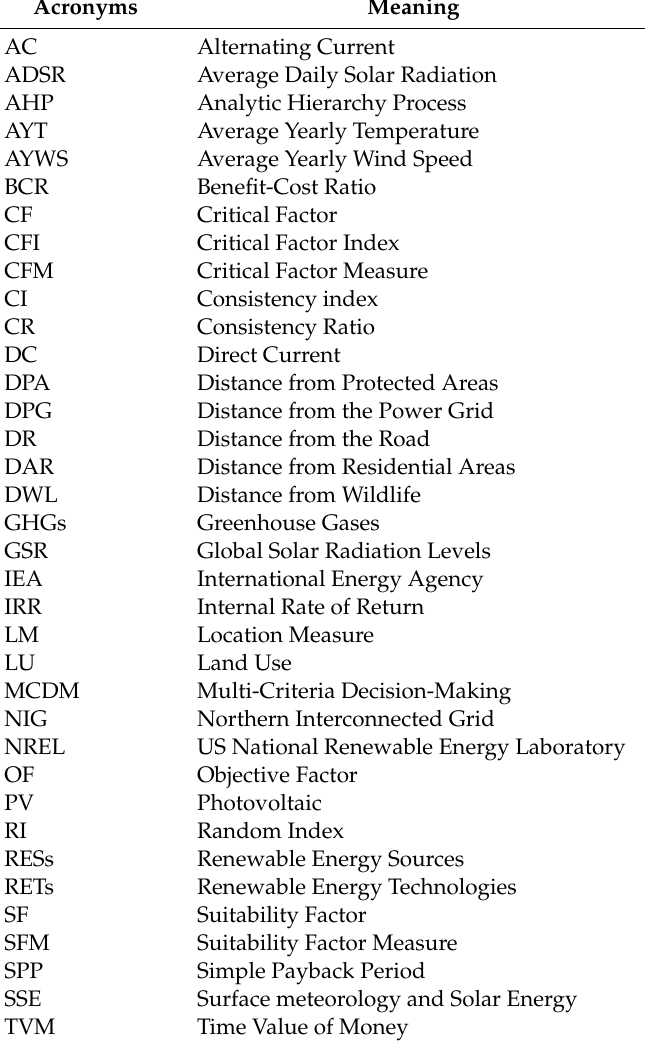
Table A1. List of acronyms used in the